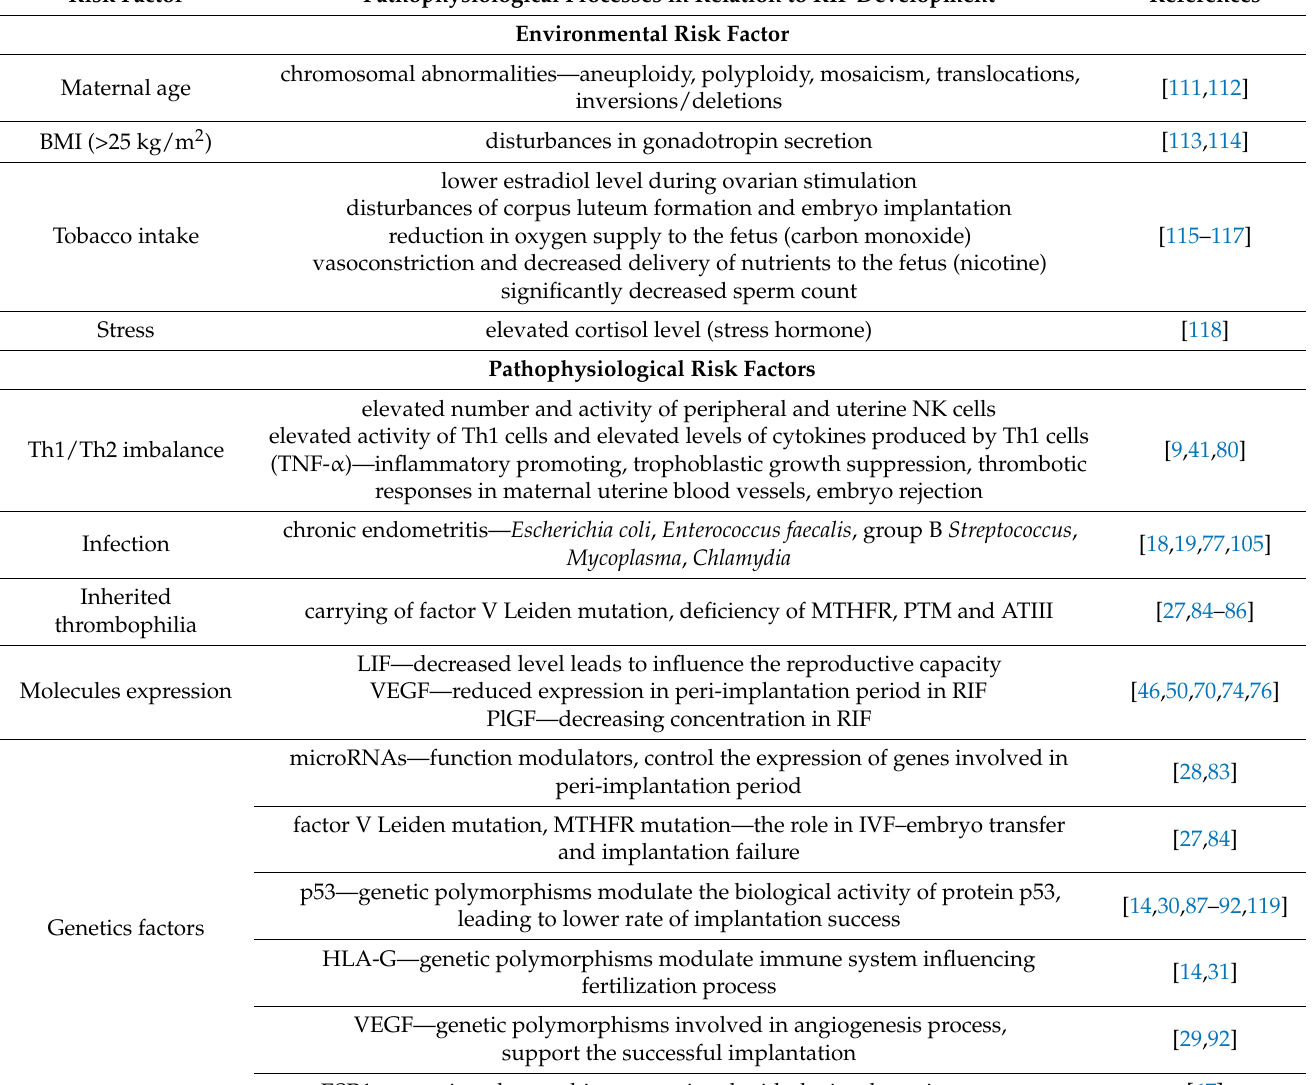
Table 2. Summary of pathophysiological processes in relation to RIF development according to environmental and pathophysi- ological risk